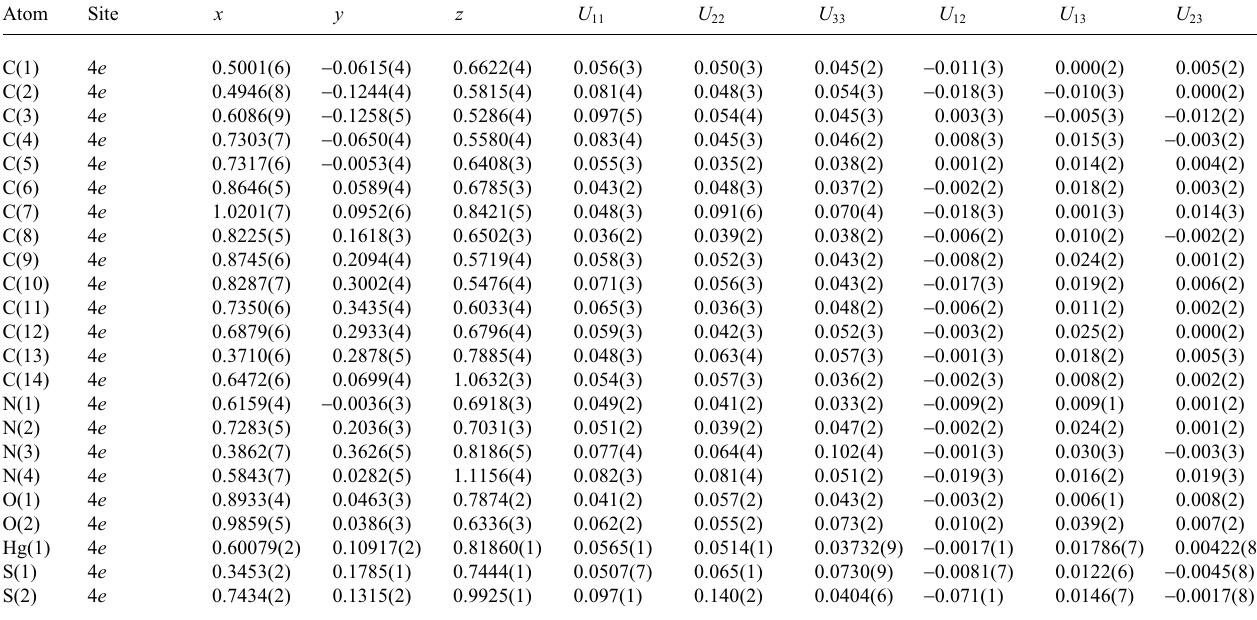
Table 3. Atomic coordinates and displacement parameters (in Å 2 ).